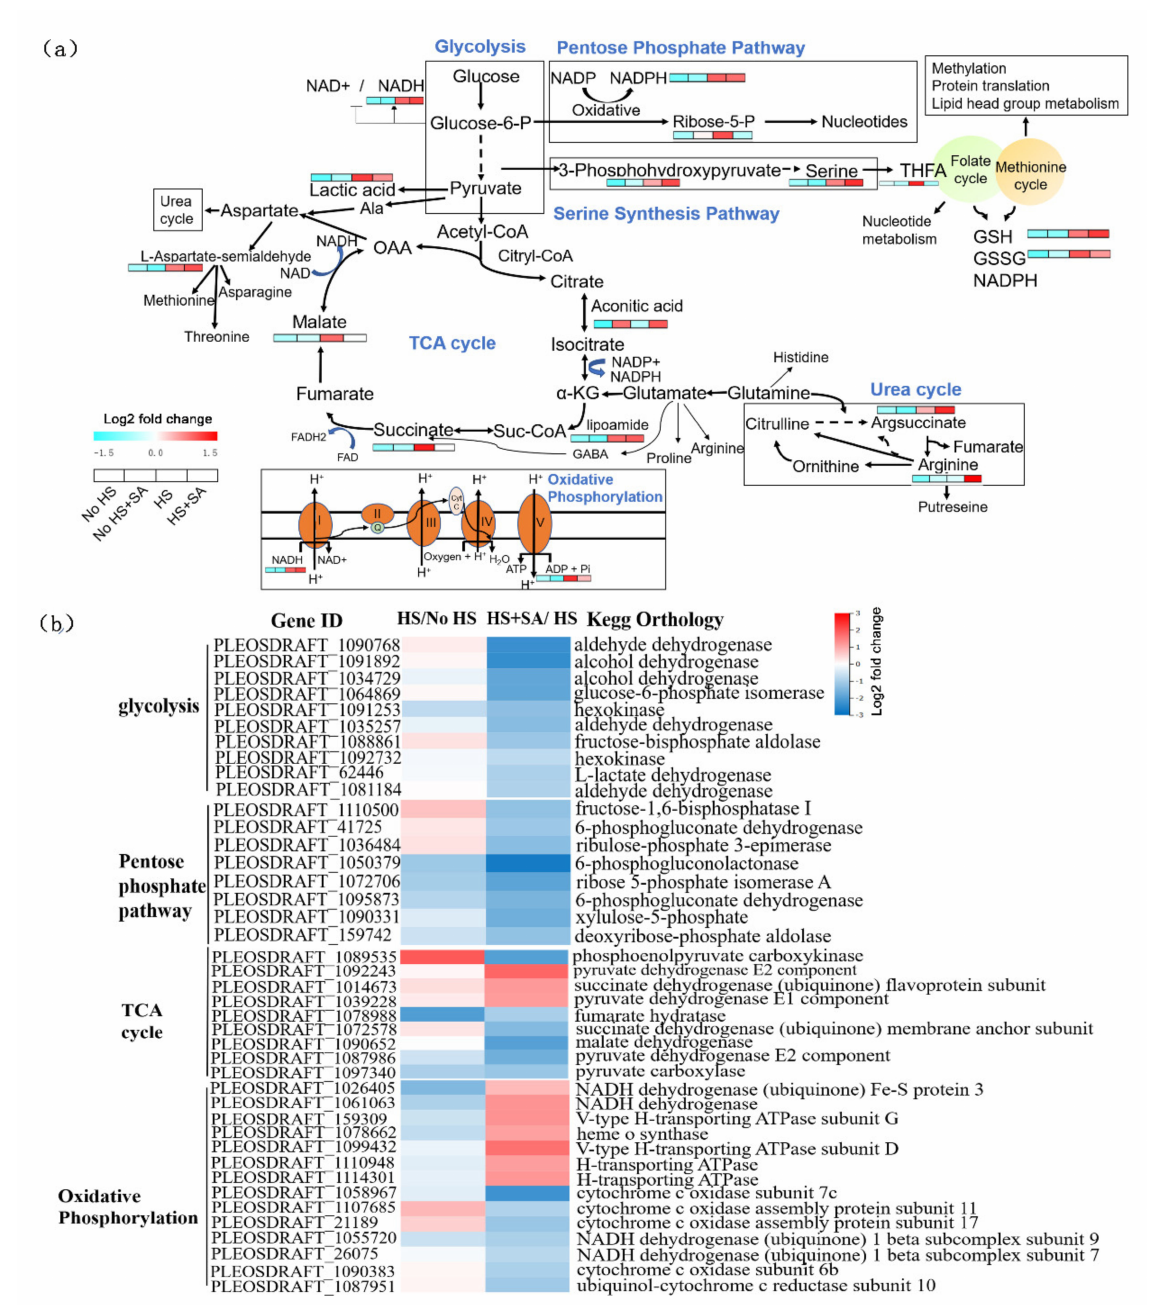
Figure 3. Energy metabolism and central carbon metabolism analyses. ( a ) Intermediate metabolite content analyse; ( b ) transcription level of related genes belonging to these metabolic